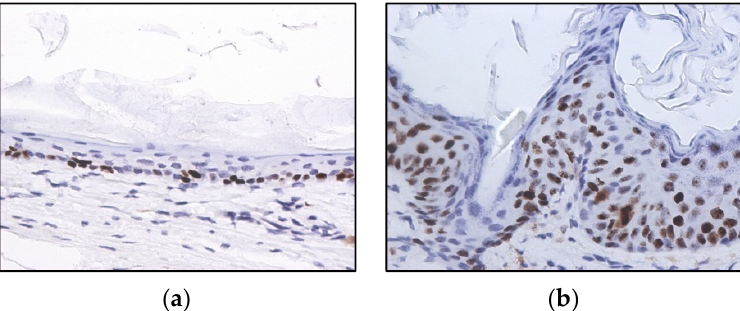
Figure 4. Immunohistochemistry for Ki67, in wild-type ( a ) and HPV16-transgenic ( b ) mouse skin. In panel ( a ), Ki67-positive cells are restricted to the basal epidermal layer. In panel ( b ), Ki67-positive cells are scattered through all epidermal layers, reflecting HPV16-induced aberrant proliferation. 3,3’ ‐ diaminobenzidine (DAB)–Mayer ʹ s hematoxylin, 400×.